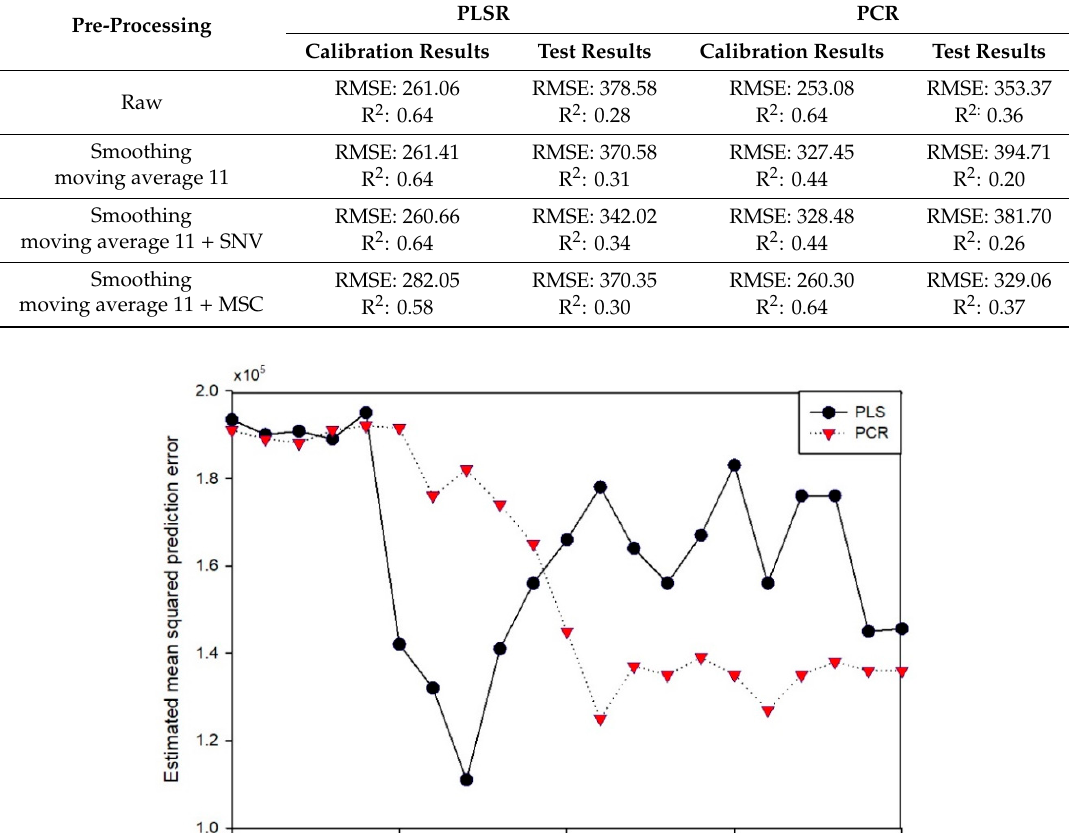
Table 4. Comparison of PLS and PCR performance analysis results for various preprocessing methods applied to the NIR spectrum data.